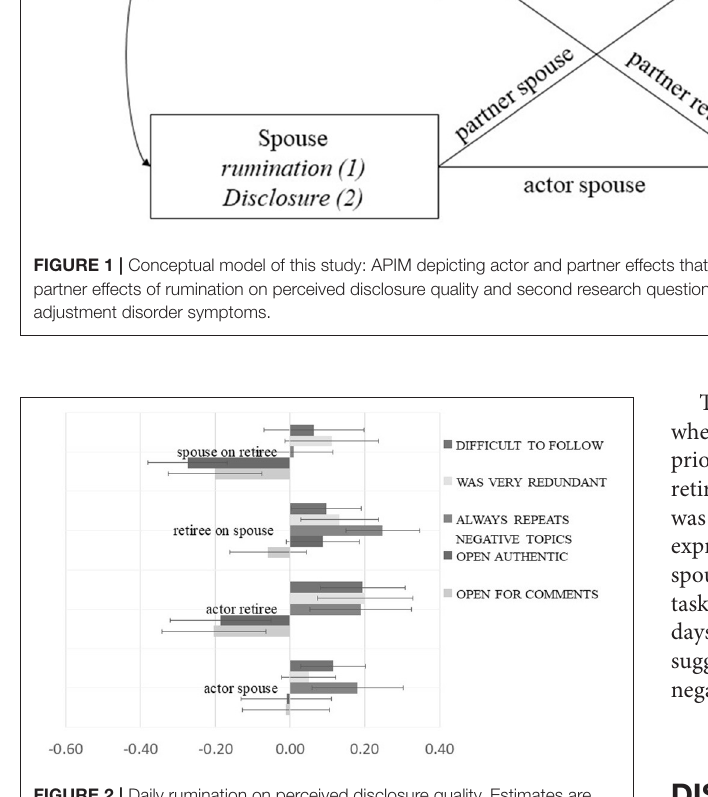
FIGURE 2 | Daily rumination on perceived disclosure quality. Estimates are unstandardized betas of double intercept (retiree/partner) APIM multilevel models controlled for gender. T-lines represent 95%